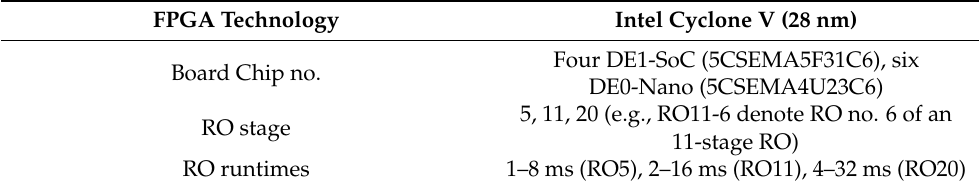
Table 1. Experimental conditions of the proposed